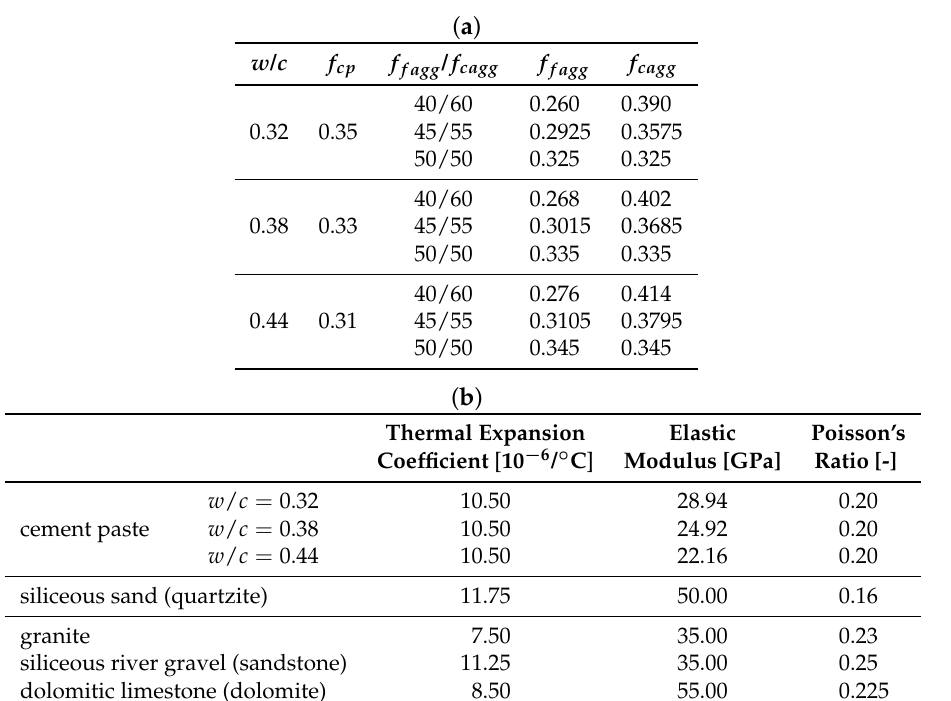
Table 3. Input for model predictions of the experiments by Sakyi-Bekoe [2]: ( a ) volume fraction and ( b ) thermoelastic properties of the cement paste, the fine aggregates and the coarse aggregates.